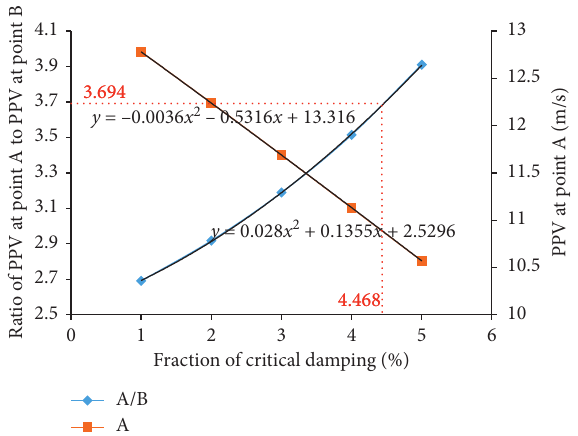
Figure 7: Graphs for calibration with respect to dynamic stress and local damping